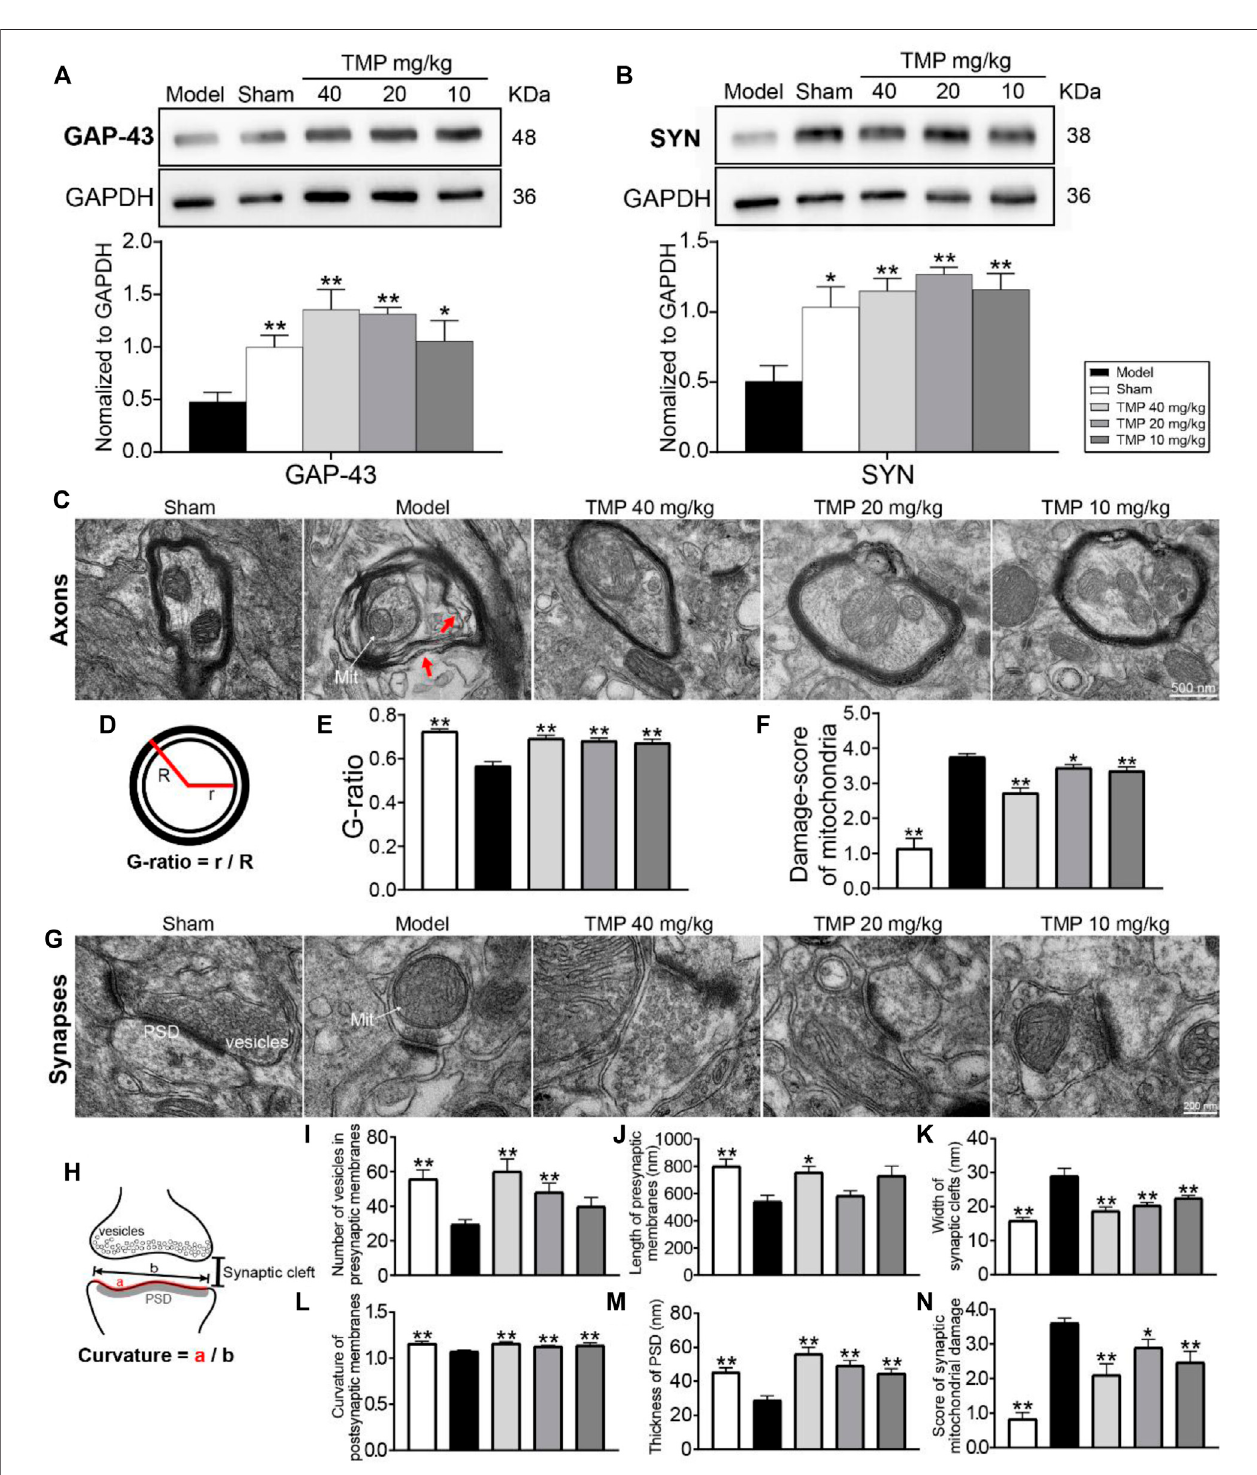
FIGURE 6 | Effects of TMP on GAP-43 and SYN expressions and axonal and synaptic microstructural damage in MCAO rats. Typical Western blot images and analysisfor (A) GAP-43and (B) SYN( n =4).Theproteinlevelswerequanti fi edwithGAPDHastheloadingcontrol. (C) RepresentativeTEMimagesofmyelinatedaxonsin each group, and the axons separating from myelin sheath (red arrows) and abnormal mitochondria (Mit) were indicated in the model group ( n = 2). (D) G-ratio indicated the axonal diameter (r)/total fi ber diameter (R). The quantitation of (E) G-ratio and (F) damage score of mitochondria in axons. (G) Representative TEM images of synapses in each group ( n = 2). (H) Vesicles in presynaptic membranes, synaptic cleft, PSD, and postsynaptic membrane curvature are shown on the schematic diagram. The quantitation of (I) vesicles in presynaptic membranes, (J) presynaptic membrane length, (K) synaptic cleft width, (L) postsynaptic membrane curvature, (M) PSD thickness, and (N) damage score of mitochondria in synapses. * p < 0.05 and ** p < 0.01 vs. Model group.